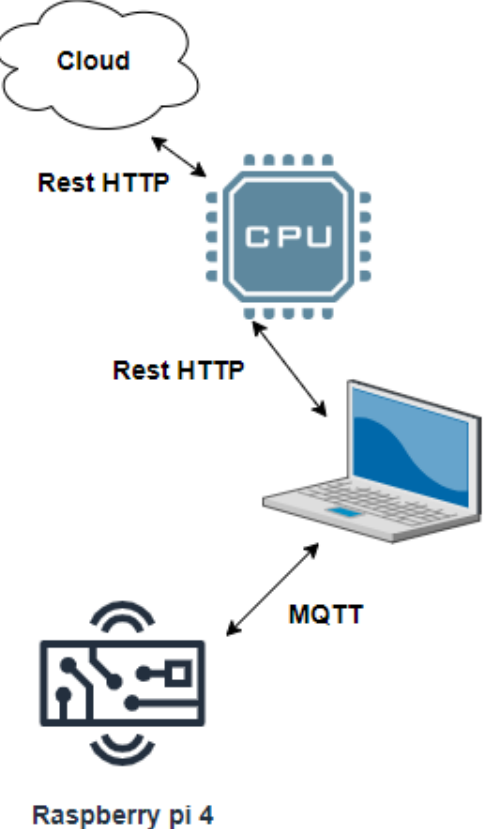
Figure 2. System architecture of the proposed epileptic seizure classification.